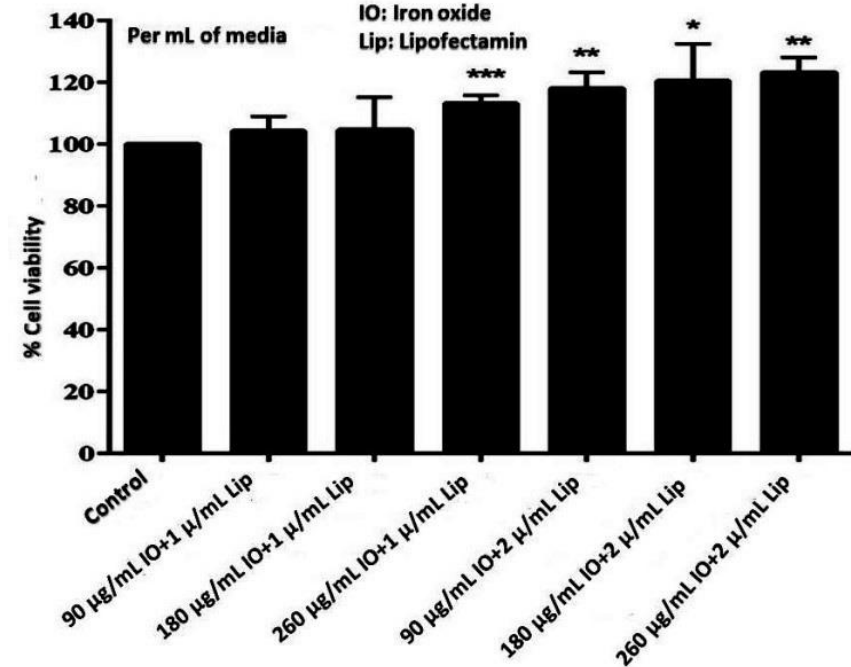
Figure 2. MTT assay regarding cell proliferation and viability of labeled cells in different concentra- tion of iron oxide nanoparticles (90, 180, 260 µg/mL) transfected with 1 and 2 µL/mL of lipofec- tamine. Data are representative of three independent experiments ( p = 0.19, * p = 0.048, ** p = 0.001, *** p = 0.003, respectively), revealing the non-toxic role of nanoparticles when transfected with lipofectamine.